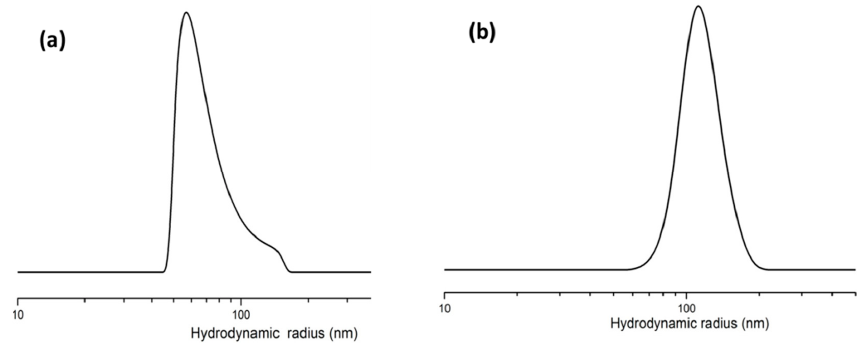
Figure 5. ( a ) Hydrodynamic radius distribution of PXA- g -S15 nanoparticles in water with a concentration of 1 g·L − 1 at 25 °C; ( b ) hydrodynamic radius distribution of PDSA- g -S10 nanoparticles (1g·L − 1 in water at 25 °C).